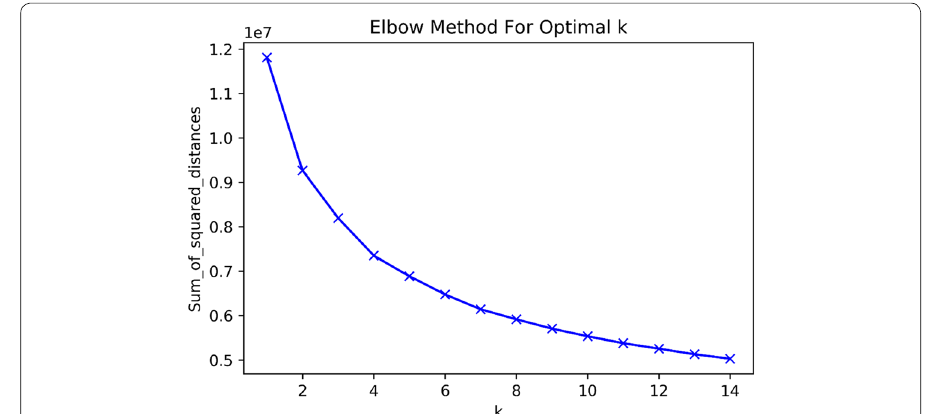
Fig. 5 Optimal number of clusters for PCA Reduced